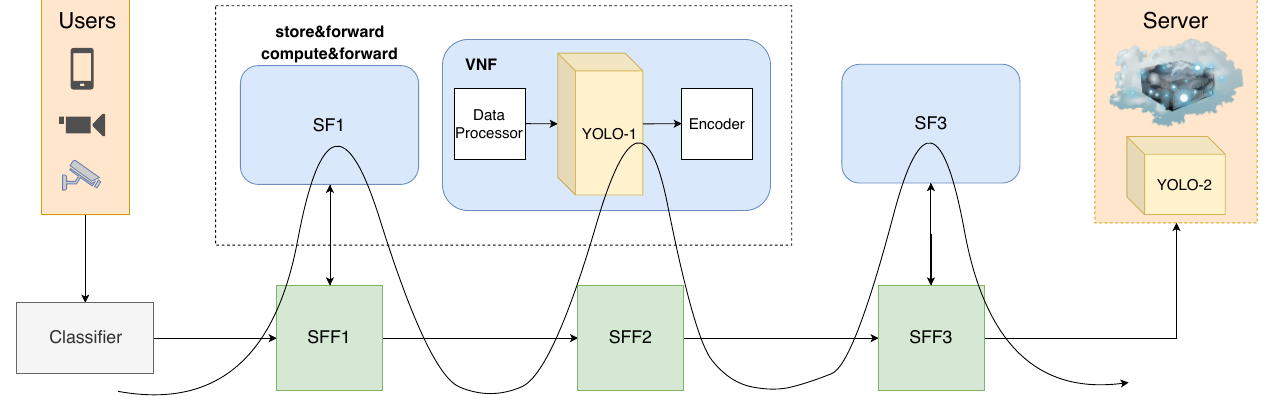
Figure 2. Overview of the distributed architecture, here for the example employing YOLO